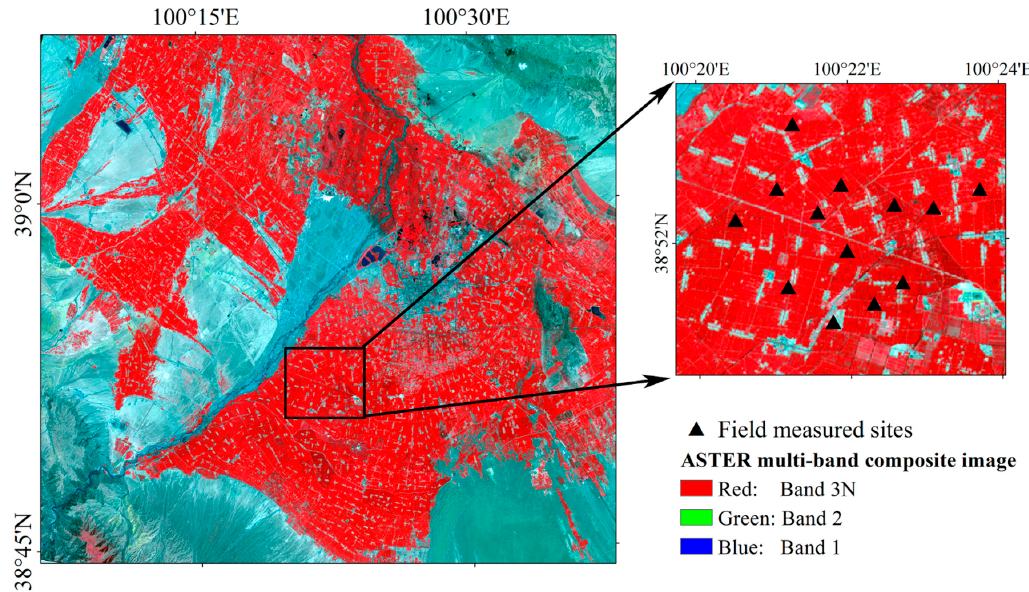
Figure 1. Map of study area and field measured sites.